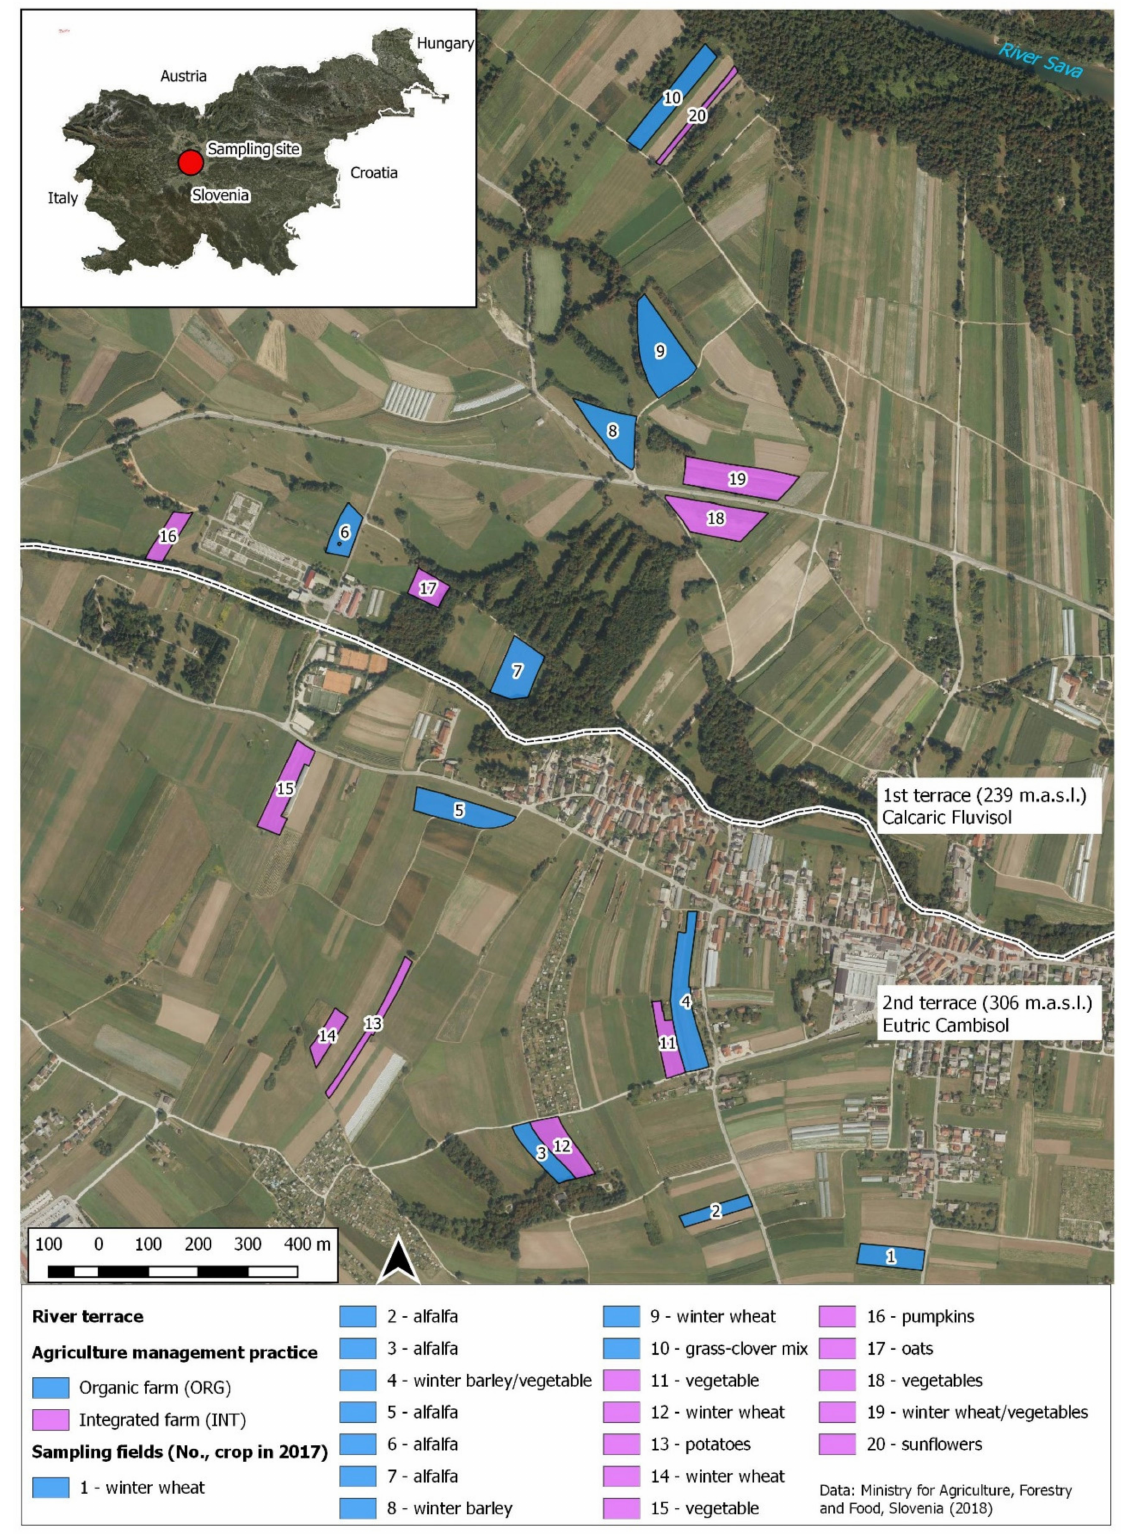
Figure 1. Research area with experimental fields under organic (blue colored fields) or integrated management (purple colored fields) in the subalpine river Sava alluvial plain in central Slovenia (data source: Ministry for Agriculture, Forestry and Food,